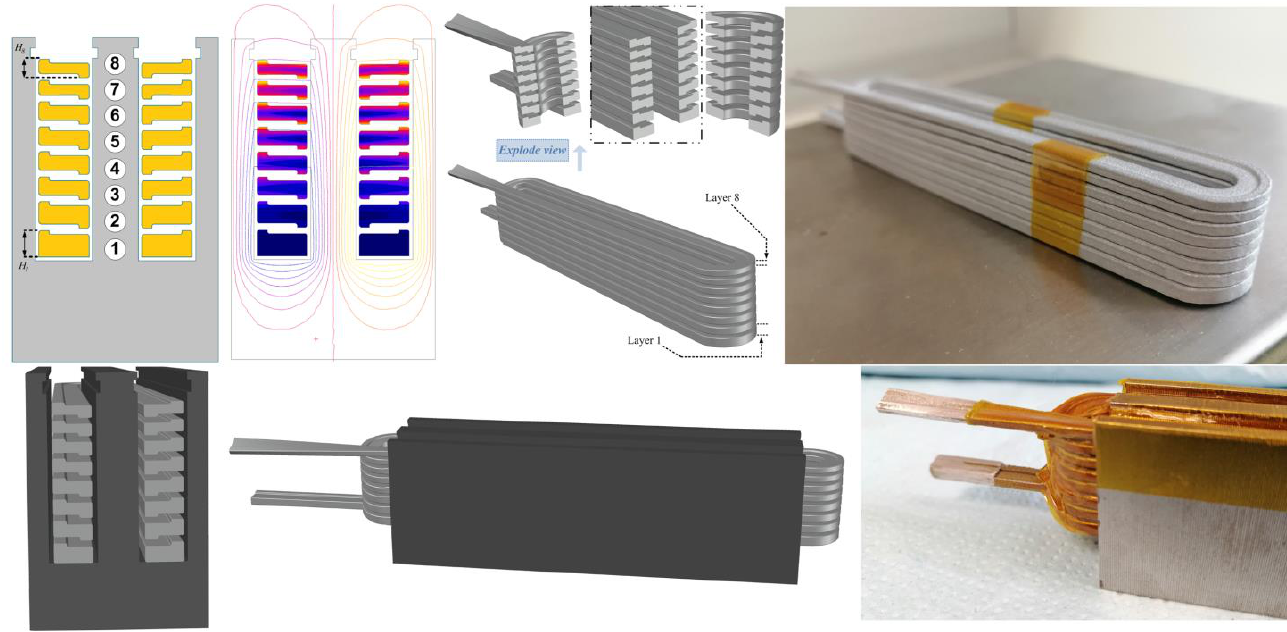
Figure 1. Shape profiled 3D printed coil with uneven turns [26].